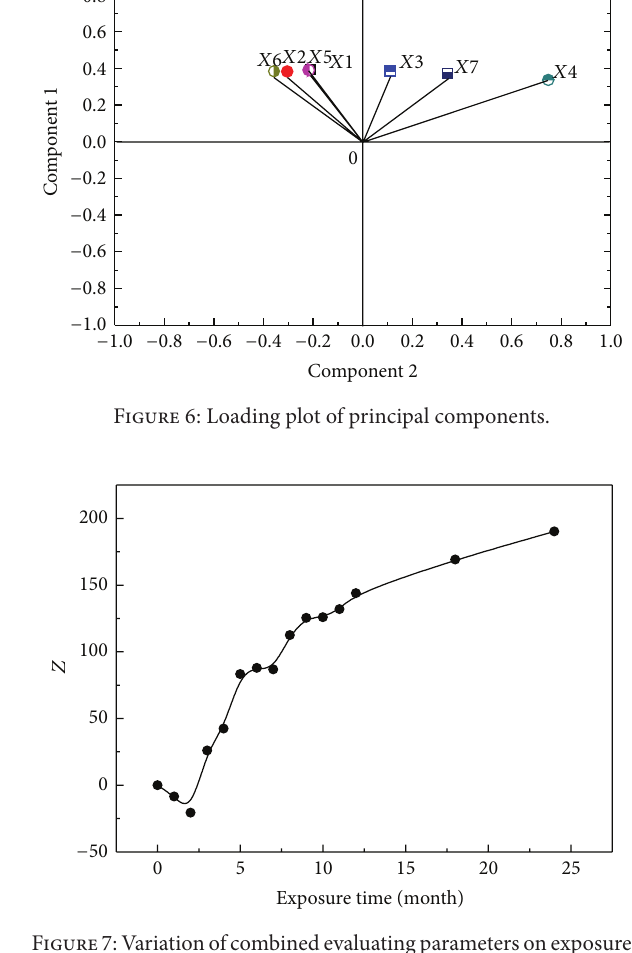
Figure 7: Variation of combined evaluating parameters on exposure